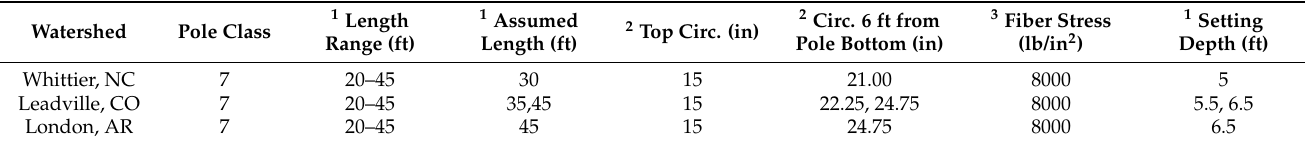
Table 2. Utility pole attributes for each watershed